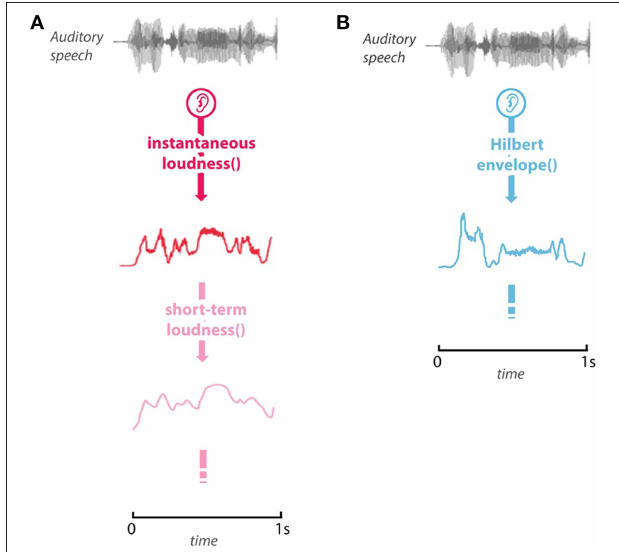
FIGURE 1 | Example of the stimulus and model predictions. (A) The predicted instantaneous loudness (red), and short-term loudness (pink) for the first 1-s of the stimulus. (B) The Hilbert envelope for the first second of the